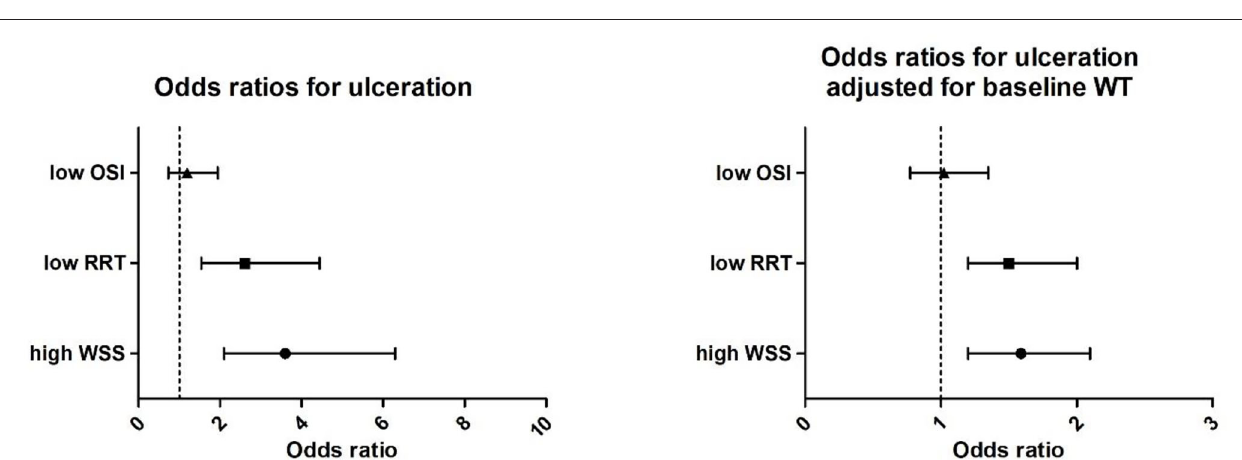
by the lower maximum values in RRT and OSI and higher odds to develop an ulcer at regions exposed to the lowest RRT